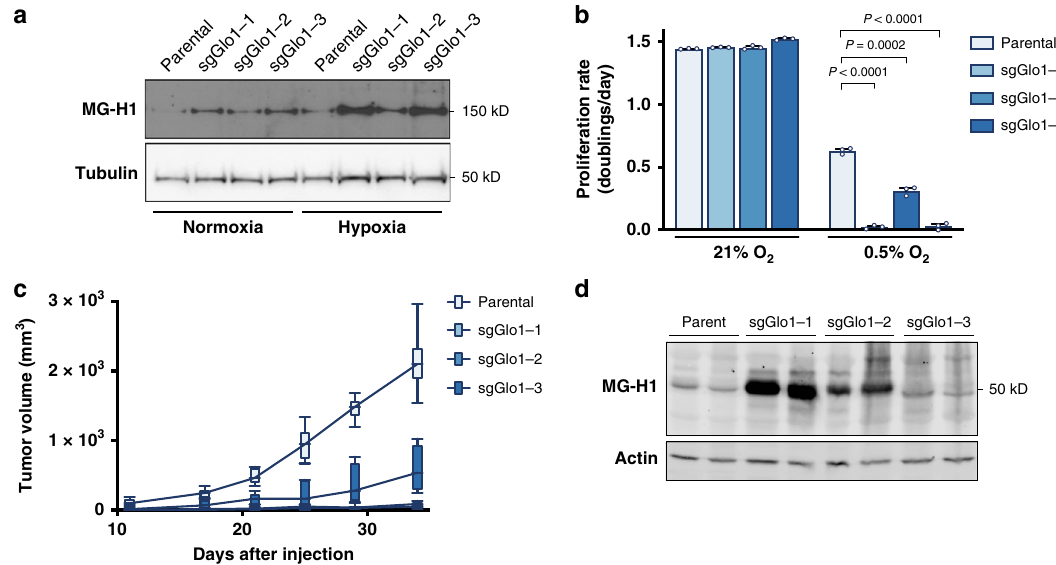
Fig. 5 Glyoxalase I supports NSCLC proliferation under hypoxic conditions and in vivo. a Western blot analysis of proteins containing the MG-H1 epitope were performed on lysates collected from 3553T3 parental cells and Glo1-deleted clones that had been cultured under normoxic and hypoxic (0.5% O 2 ) conditions for 72 h. b Proliferation rate of 3553T3 parental cells and Glo1-deleted clones when cultured under normoxic and hypoxic (0.5% O 2 ) conditions. Values indicate mean ± SEM, and P values were calculated by unpaired, two-tailed Student ’ s t -test ( n = 3). c Tumor growth over time of allografts generated from 3553T3 parental cells and Glo1-deleted clones. The tumor volume for each genotype is depicted as a box and whisker plot for each time point. The difference in tumor growth between parental cell lines and Glo1-deleted clones was signi fi cant for every comparison ( P < 0.0001 by two-way ANOVA; n = 6). d Western blot analysis using an antibody raised against the MG-H1 epitope of lysates from tumor allografts harvested at the end point of the experiment shown in d